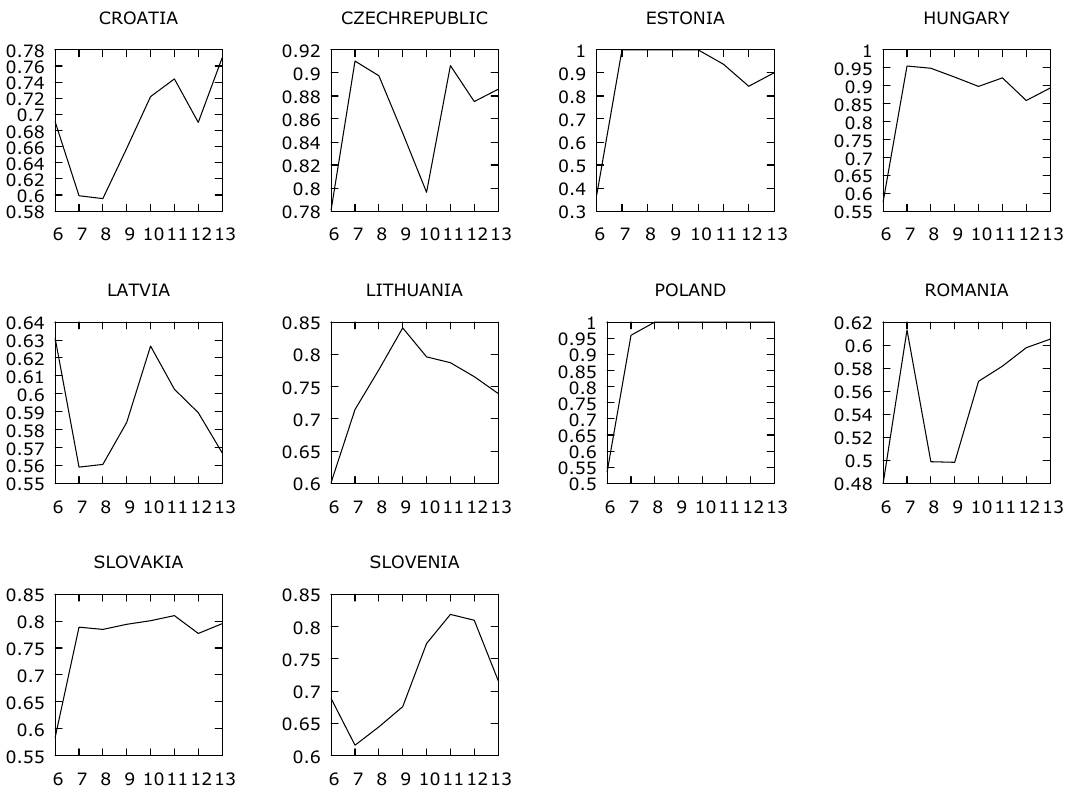
Figure 5. Average Efficiency2 banks in CEE countries. Source: processing using data from BankScope. The years on the x -axis are marked as follows: 2006 as “6”, 2007 as “7”, 2008 as “8”, 2009 as “9”, 2010